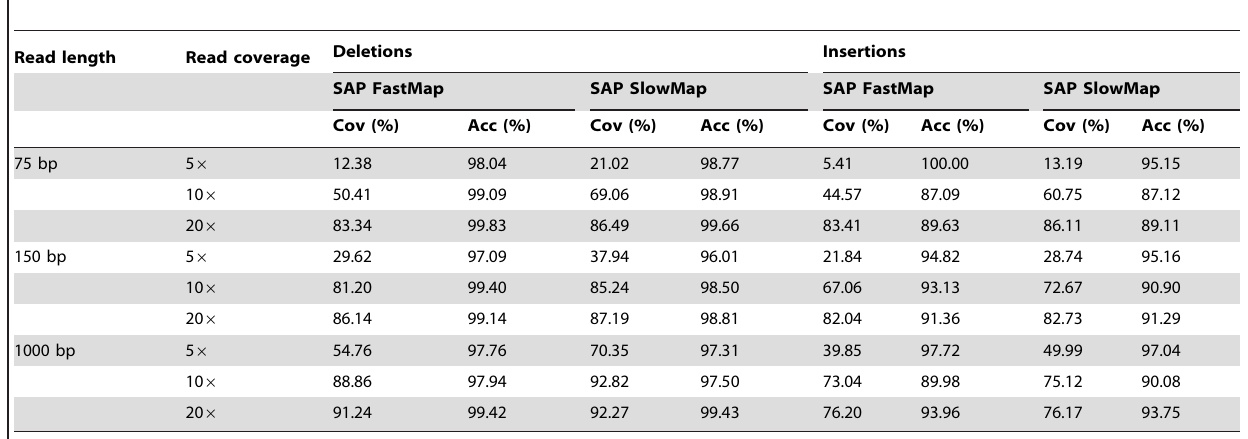
Table 5. Performance of SAP on detecting InDels in simulated